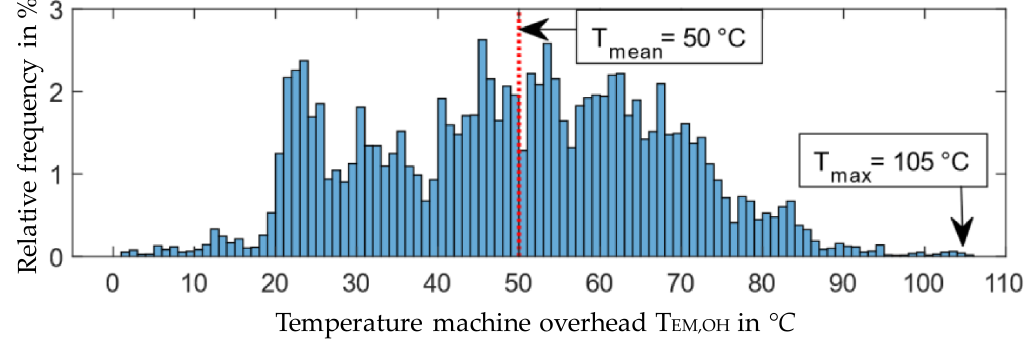
Figure 5. Machine winding overhang temperature for the NEmo.